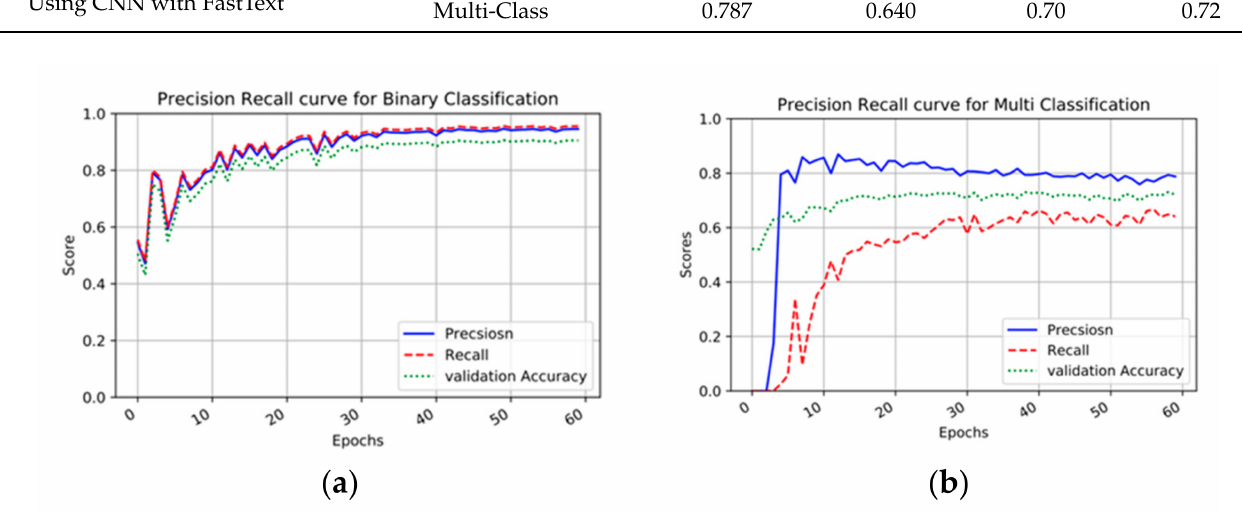
Figure 2. Precision-recall and validation curves, using CNN model for binary and multi-classification. ( a ) PR curves for binary-classification; ( b ) PR curves for